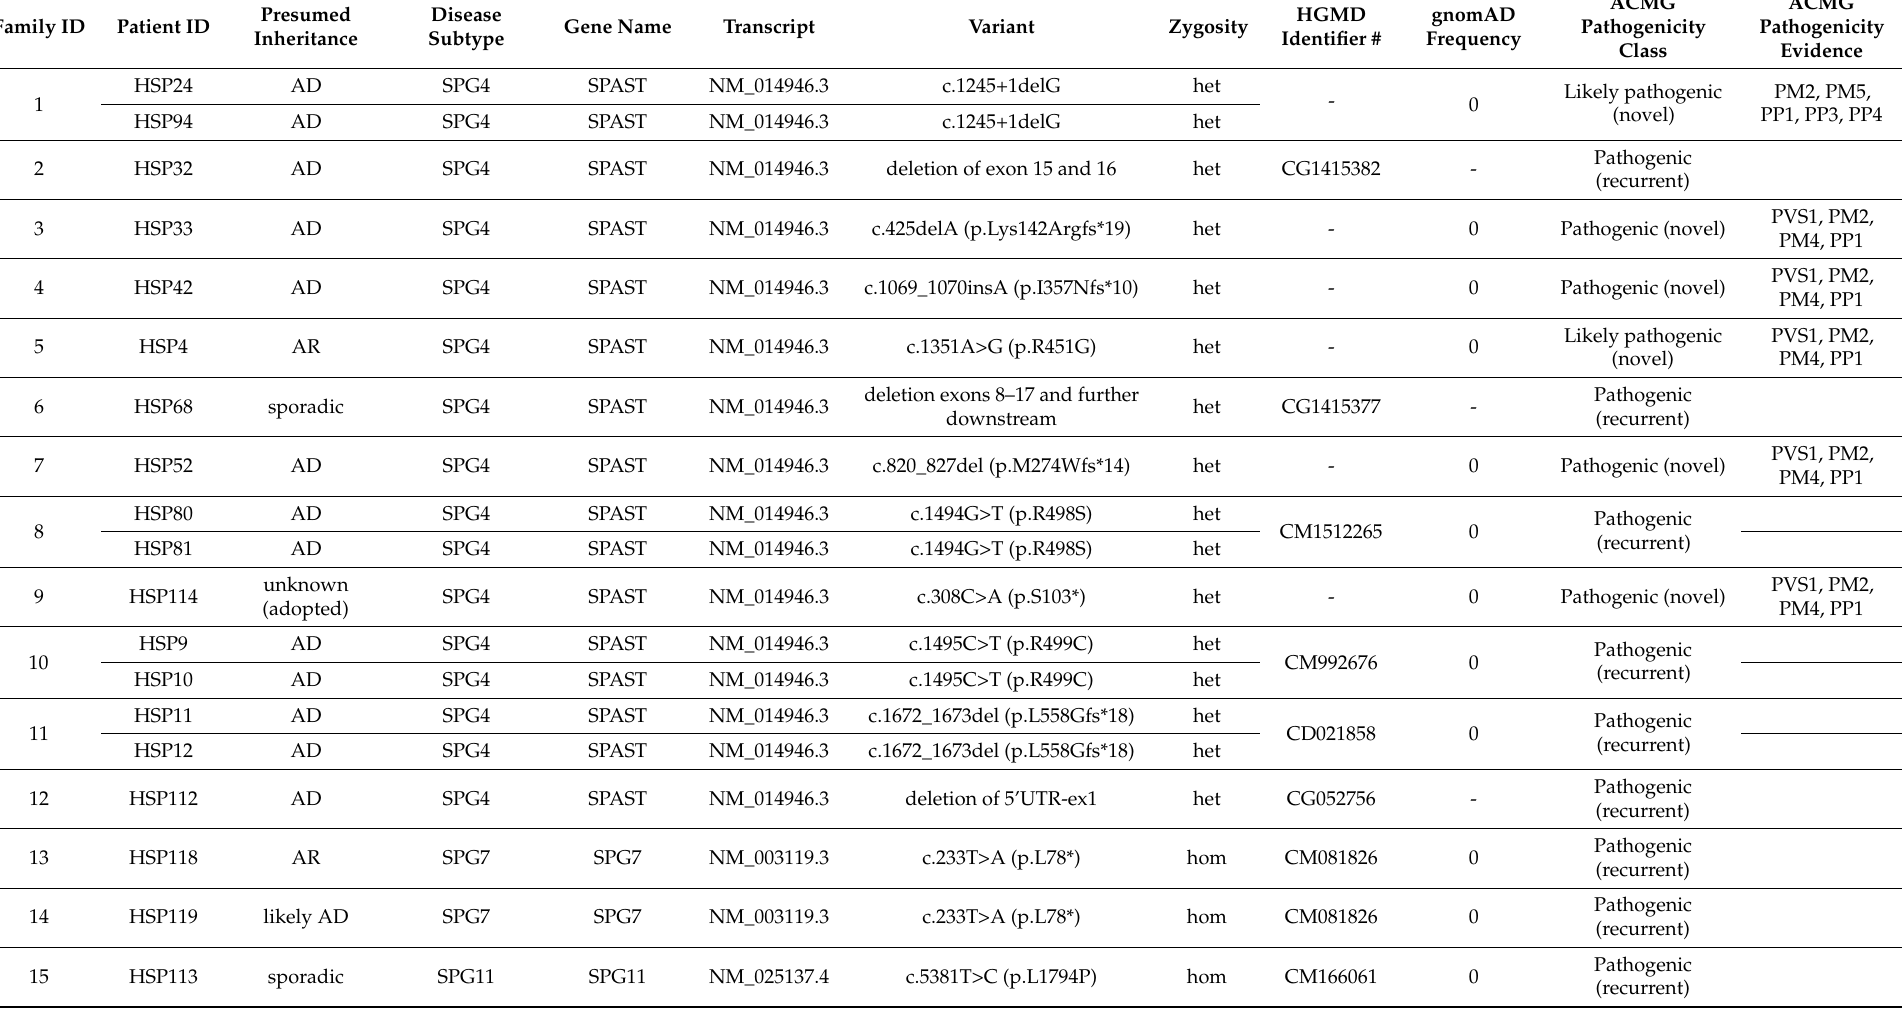
Table 1. Genetic findings in the analyzed Serbian adult HSP